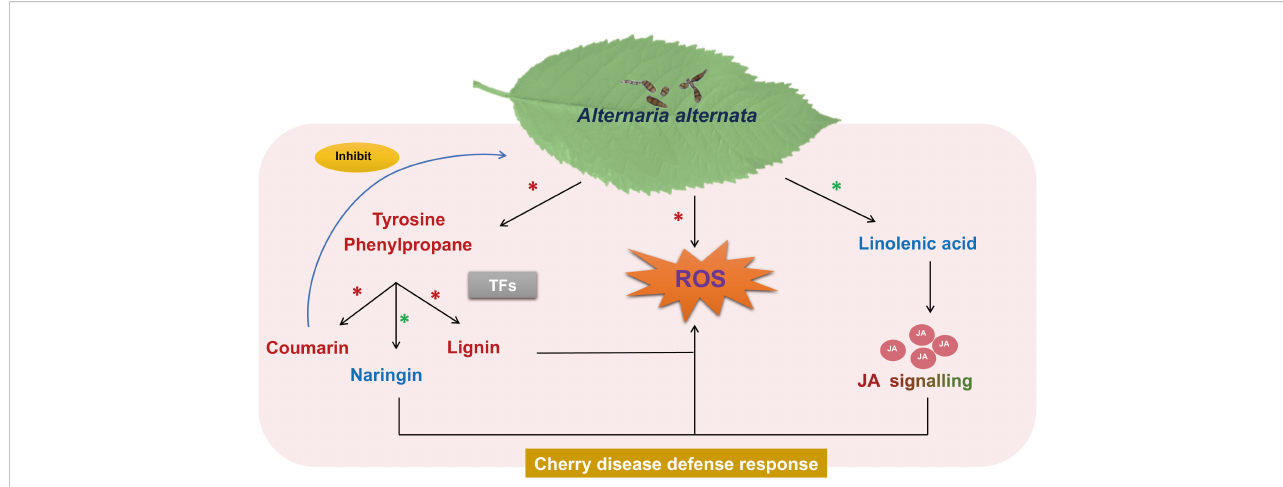
FIGURE 9 The proposed defense response mechanism of cherry to A. alternata infection. ROS are the core defense responses of cherry to A. alternata ; JA, phenylpropanoid, and fl avonoid biosynthesis are the key pathways, coumarin could effectively inhibit the growth of A. alternata , and TFs could be the key responsive factor in the response of cherry to A. alternata . The black line is induction of a process, blue line represents inhibition. Metabolite name indicated in red or blue represent signi fi cant accumulation in the RC or SC, respectively. The words indicated by gradient colors, which represent the signi fi cant accumulation of JA signaling in RC at an early stage. Red asterisks (*) indicate up-regulation in the resistance response, green asterisks (*) indicate down-regulation in the resistance